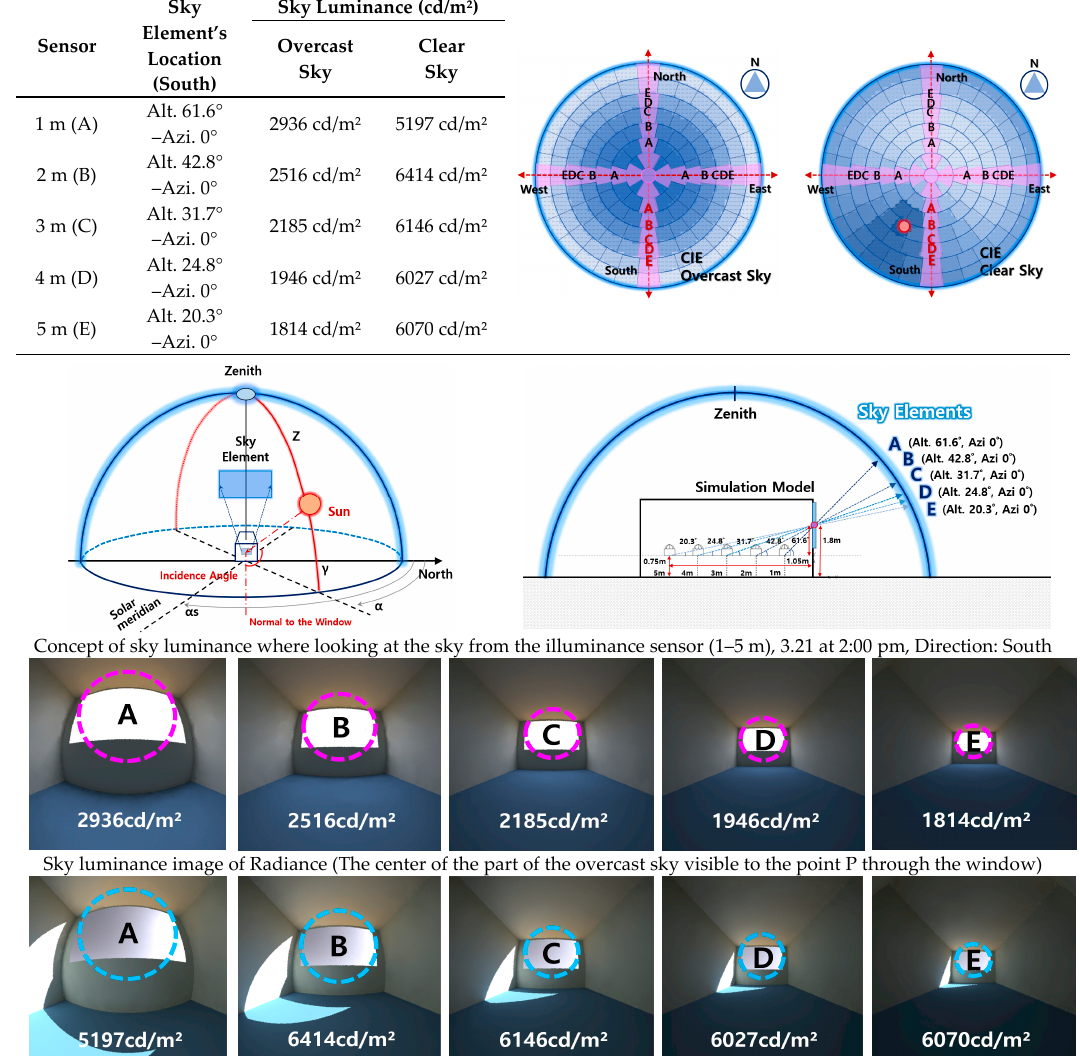
Table 9. Image of Desktop Radiance, concept diagram, and sky luminance from looking at each sensor.